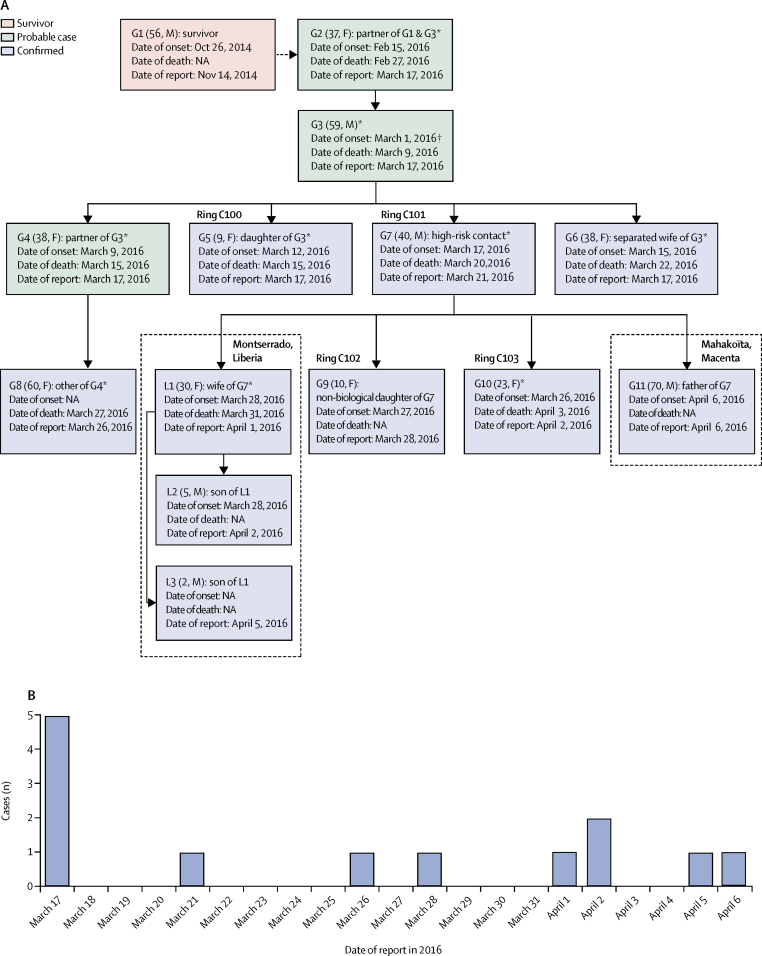
Probable chain of transmission in Guinea, from February to April, 2016(A) Chain of transmission. (B) Date of confirmed cases refers to date of an RT-PCR positive diagnosis. Reproduced from Diallo and colleagues,5 by permission of Oxford Journals. G=case in Guinea. L=case in Liberia. M=male case. F=female case. NA=not available. *Died. †Possible date of onset.